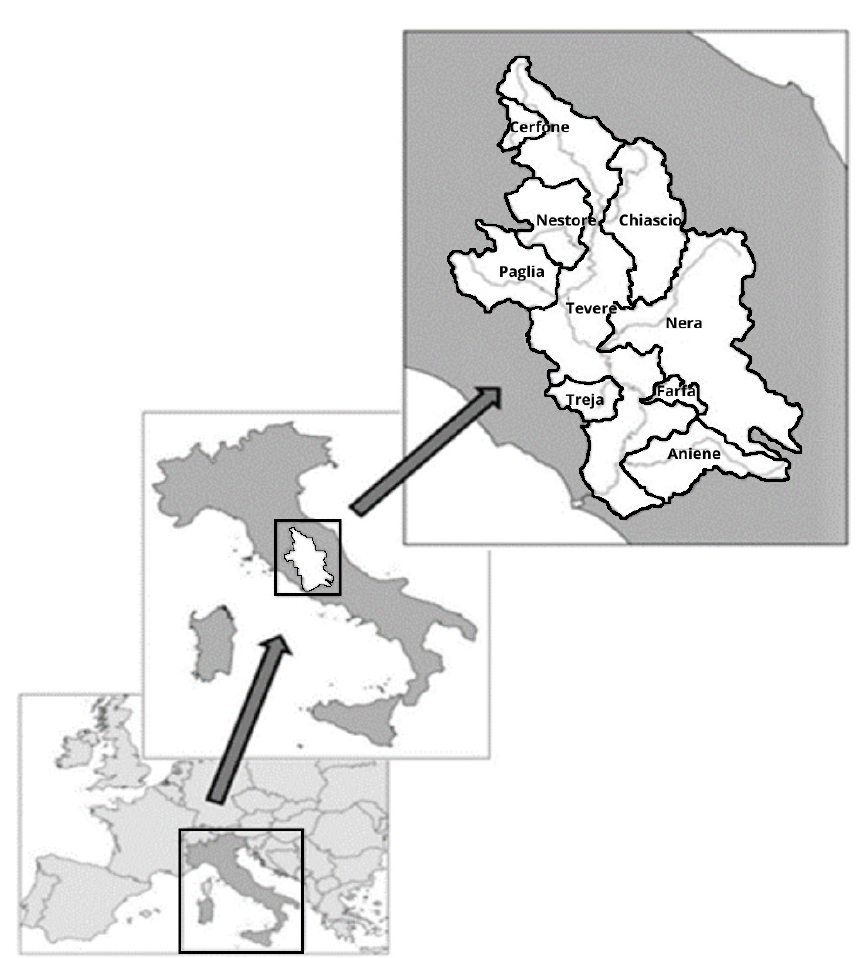
Figure 1. The Tiber River catchment area and the tributaries’ sub-catchments. Table 1. Data regarding the Tiber River catchment (TRC) and its sub-catchments. All of the data come from the database of the Italian National Institute of Statistics (ISTAT), which was produced as part of the sixth agricultural census in